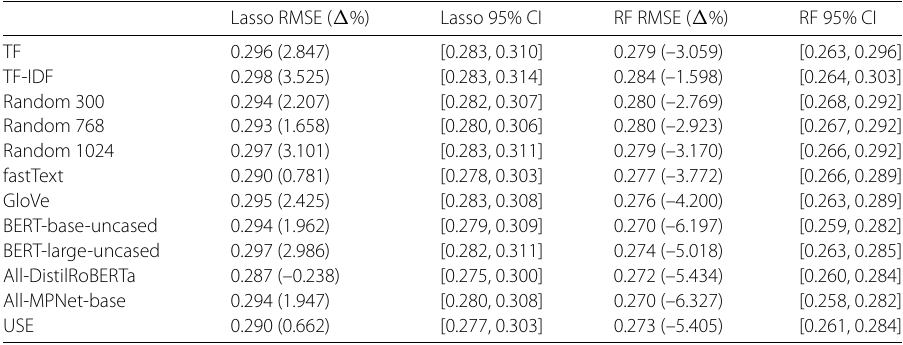
Table 6 Results of the Predictive Validity Analysis. RMSE is the root-mean-square error between predicted and observed scores. (cid:3) % in the parentheses indicates the percentage change in RMSE in comparison to the baseline RMSE: 0.288. 95% CI refers to the 95% confidence interval around RMSE Lasso RMSE ( (cid:3) %) Lasso 95% CI RF RMSE ( (cid:3) %) RF 95% CI